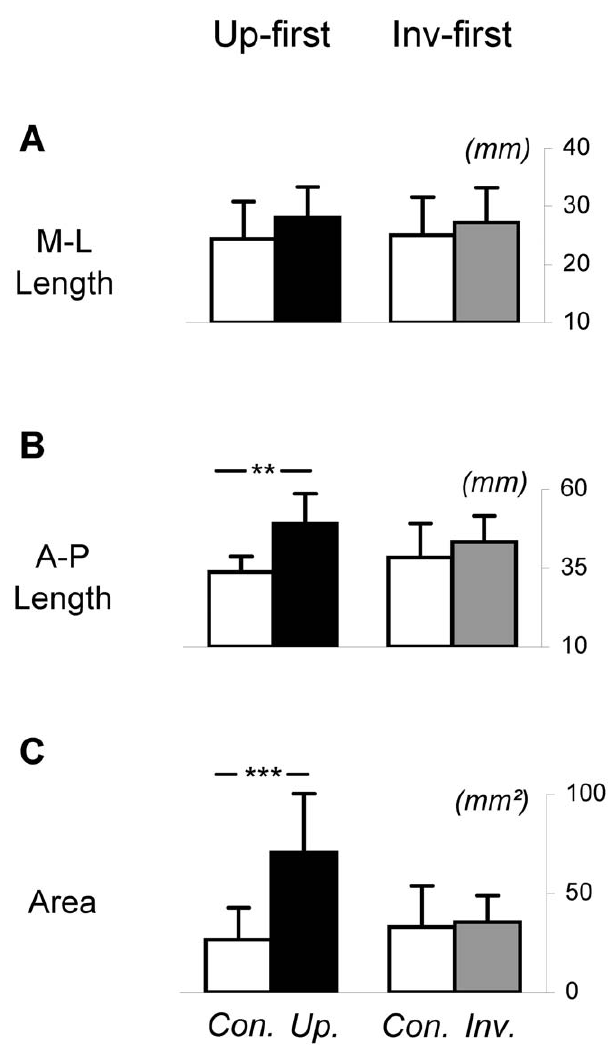
Figure 4. Mean lengths and area of CoP excursions: compar- ison between groups Up-first and Inv-first. Panels A, B and C respectively show mean medio-lateral length, antero-posterior length and area covered by CoP excursions in the Control and Upright conditions for Group Up-first, and Control and Inverted conditions for group Inv-first. Bars indicate standard deviations, ** and *** mean significant differences between conditions (respectively p , 0.01 and p , 0.001). Con. = Control condition, Up. = Upright condition, Inv. = Inverted condition. As can be seen, A-P CoP displacement and CoP area were significantly higher in the Upright condition compared to the Control condition for Group Up-first. No significant difference was detected between theInverted and Controlconditions for group